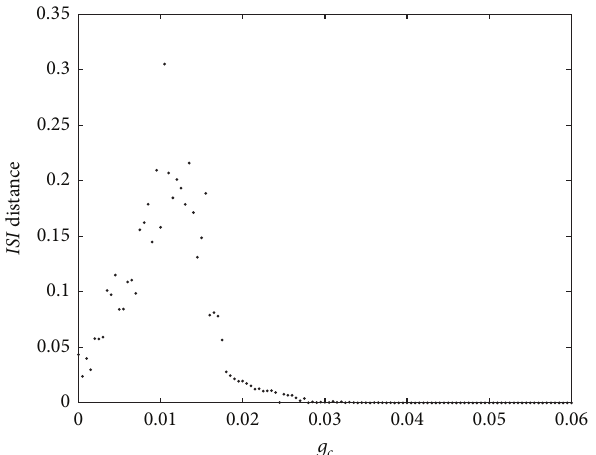
Figure 4: Plot of the ISI distance of two coupled neurons as a function of coupling strength 𝑔 𝑐 .